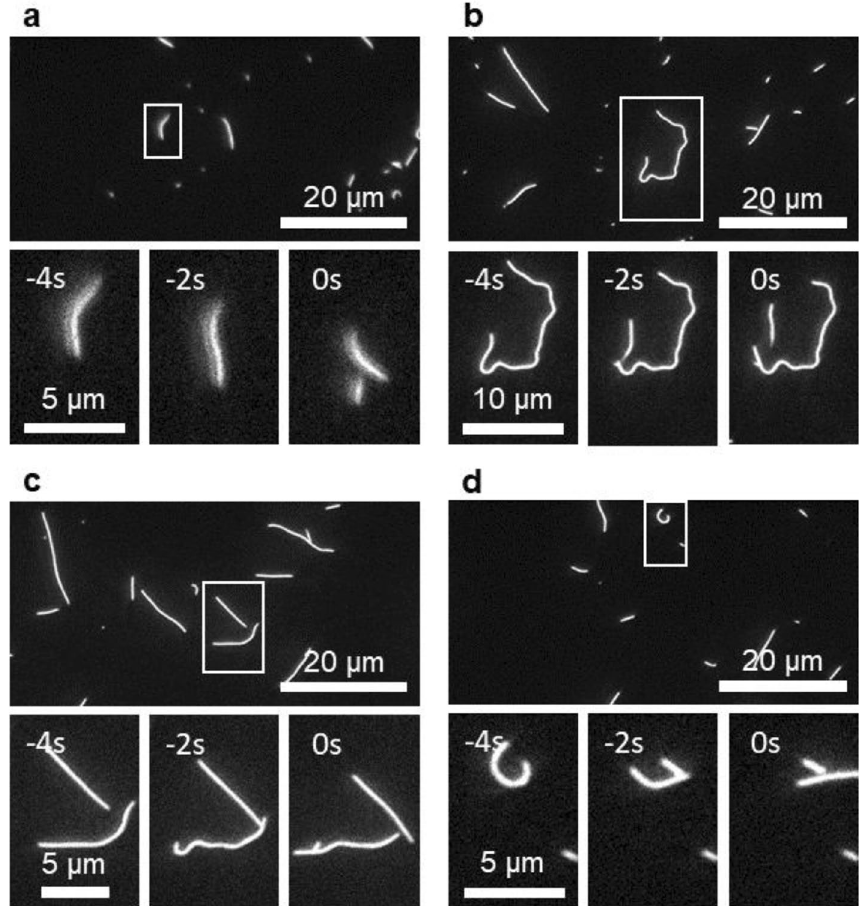
Figure 1. Fluorescence microscopy images of microtubule breaking. ( a , b ) Breaking while smoothly gliding. ( c , d ) Breaking while